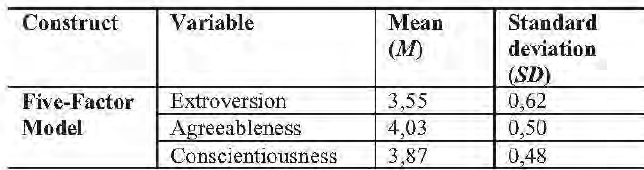
Table 2: Means and standard deviations of personality